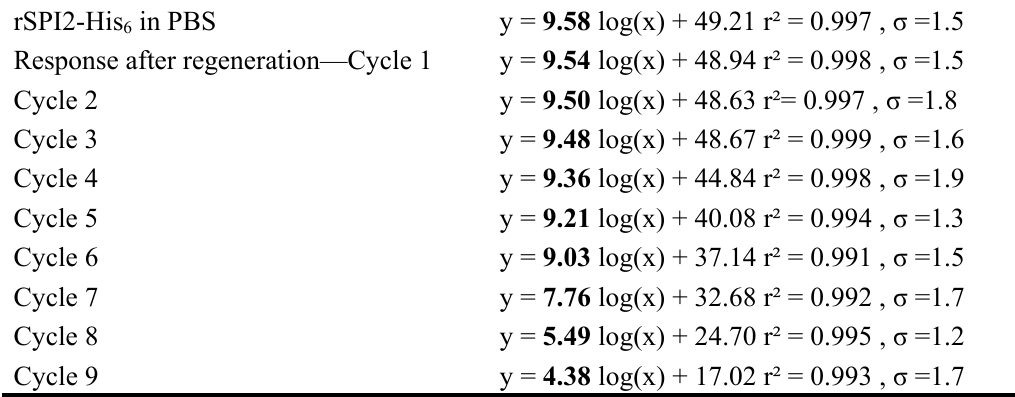
Table 2. Regeneration of the immunosensor incorporating Anti-His IgG F(ab’) fragment regenerated with 0.1 M Gly-HCl pH 2.8 buffer. Response measured by EIS towards in PBS buffer pH rSPI2-His 6